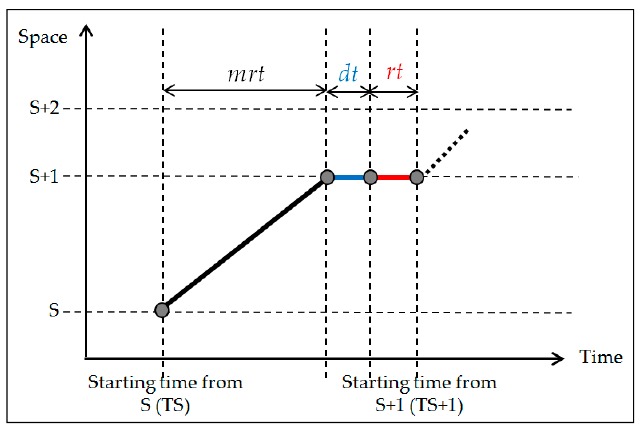
Figure 1. Scheduled timetable scheme. mrt , minimum running time; dt , dwell time; rt , reserve time.